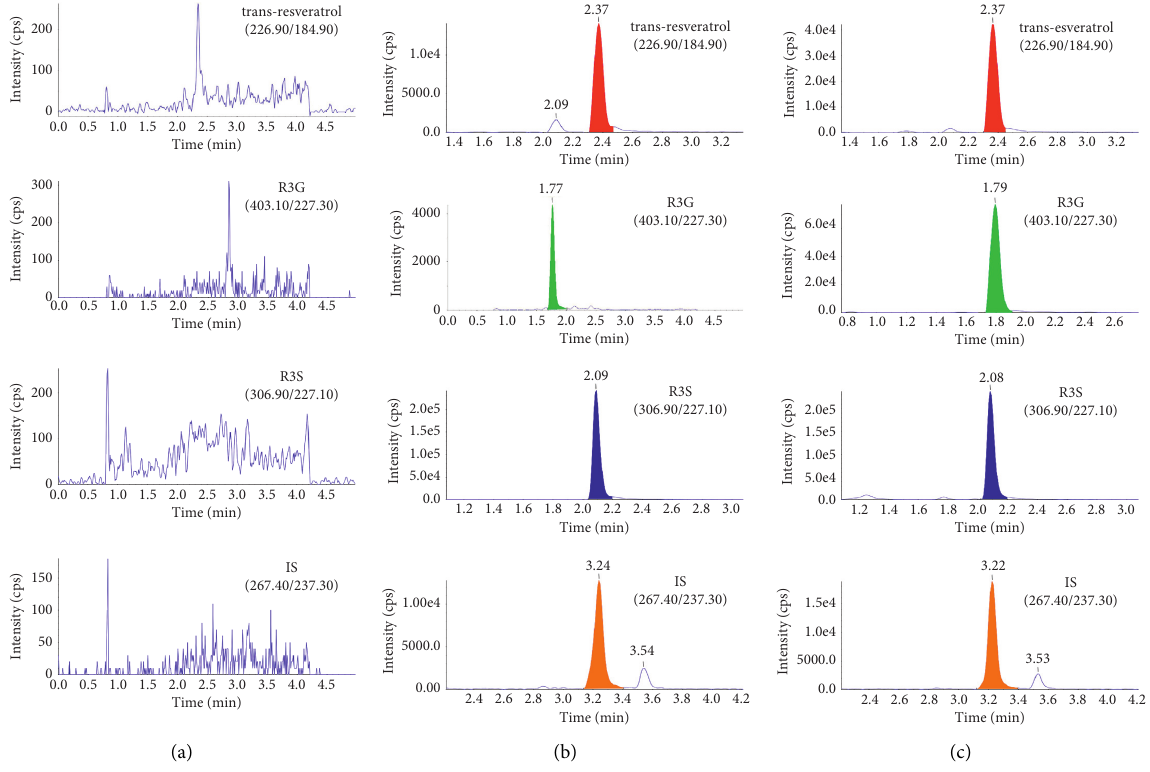
Figure 3: Typical multiple-reaction monitoring chromatograms of (a) a blank mouse blood; (b) a blank mouse blood sample spiked with trans-resveratrol, R3G, R3S, and IS; and (c) a blood sample 1h after the intragastric administration of 150mg/kg Table 2. For the devised assay, the relative standard deviation of the precision for the analytes was 3.0–10.9% for the intrabatch samples and 6.07–12.22% for the interbatch samples. Intrabatch accuracy was 90.3–112.6% and inter- batch accuracy was 91.57–106.83% for all the analytes. The results met the FDA guidelines for the bioanalytical vali- dation of precision and accuracy.